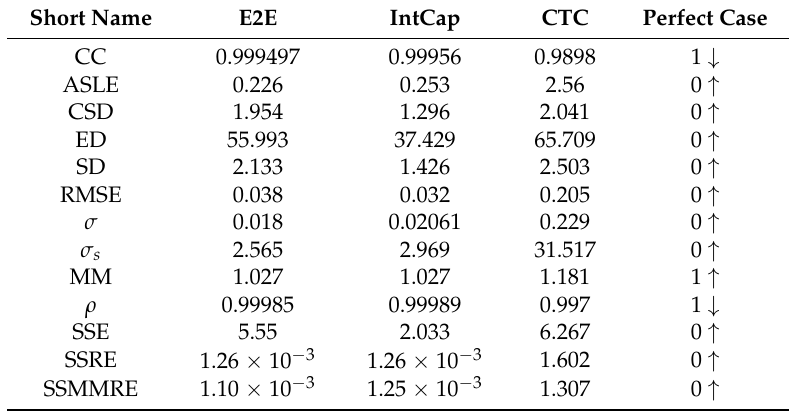
Table 2. Numerical indices results for laboratory tests—deformation 1 (frequency range 20 kHz– 1.128 MHz).